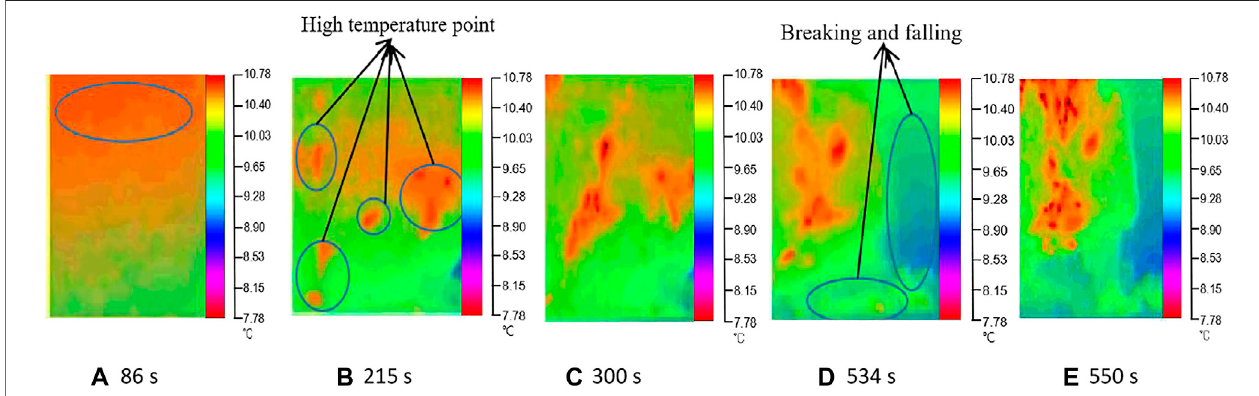
FIGURE 13 | Equalization treatment: compression of phosphate rock specimens loaded at 0.01 mm/s. (A) 86 s, (B) 215 s, (C) 300 s, (D) 534 s, and (E) 550 s.